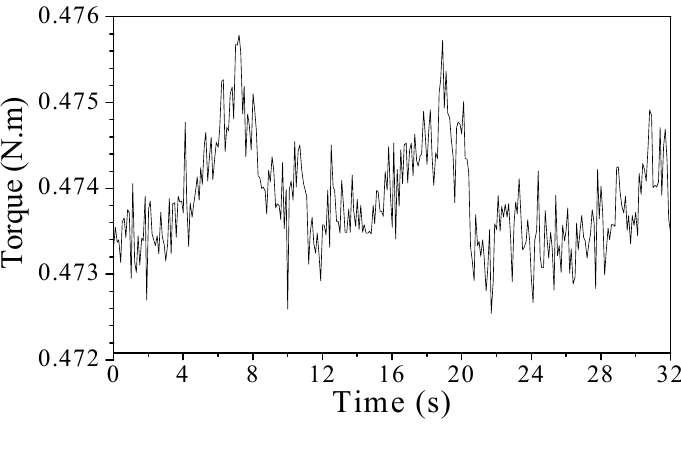
Figure 13. Measured torque at